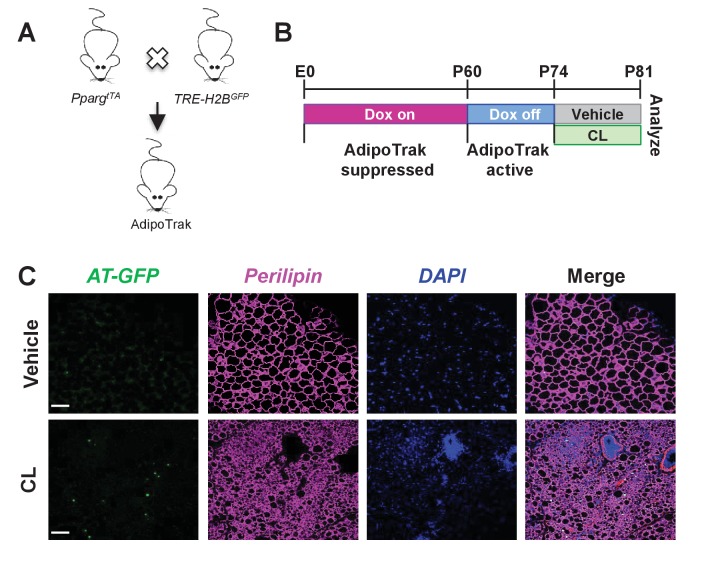
Adrb3 induced beiging is not generated by an adipose progenitor cell.(A) Genetic illustration to generate AdipoTrak mice. (B) Illustration of experimental paradigm: AdipoTrak mice were Dox suppressed from E0 until P60. Two weeks off Dox, mice were administered vehicle or CL for seven days (n= 6/group). (C) Representative immunostaining of GFP, Perilipin, and DAPI from IGW depot sections from mice described in (B). Scale bar = 200 µm.